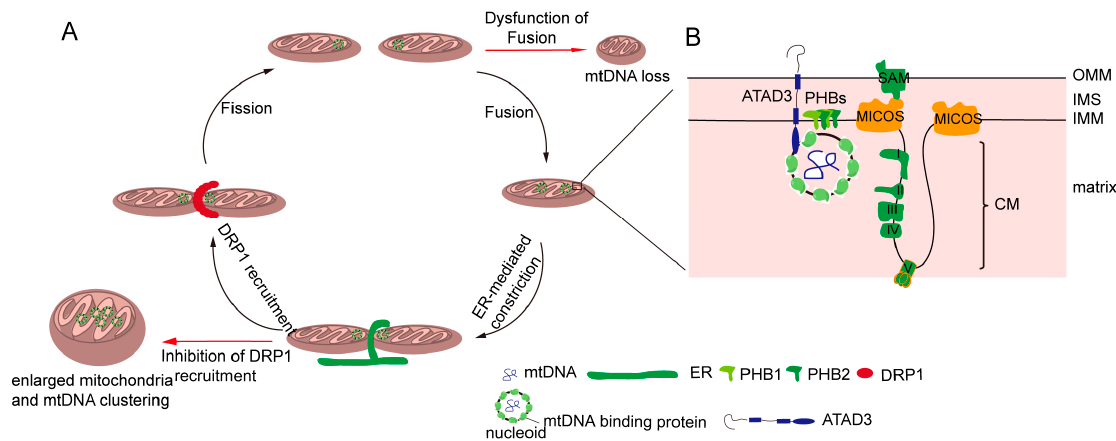
Figure 1. Regulation of the distribution of mitochondria DNA (mtDNA). ( A ) Mitochondrial dynamics regulate mtDNA. Mitochondrial fission and mtDNA segregation happened synchronously, and occur at the ER and mitochondrial contact site. Upon fission, the endoplasmic reticulum (ER) wraps the mitochondria, and then the cytosolic dynamic protein Drp1 is recruited to mediated mitochondria division. Blocking the fission leads to enlarged mitochondria and an mtDNA cluster. Mitochondrial fusion allows for two mitochondrial exchange substances, including mtDNA. The dysfunction of fusion leads to mtDNA deletion. ( B ) The mitochondrial inner membrane is involved in mtDNA distribution. Certain mitochondrial inner membrane proteins such as prohibitins and ATPase family AAA domain-containing protein 3 (ATAD3) are mtDNA-binding proteins. In addition, mtDNA nucleoid contacts with the mitochondrial cristae junction, and MICOS complex and Sam50, which are involved in the maintenance of the cristae structure, regulate mtDNA distribution.